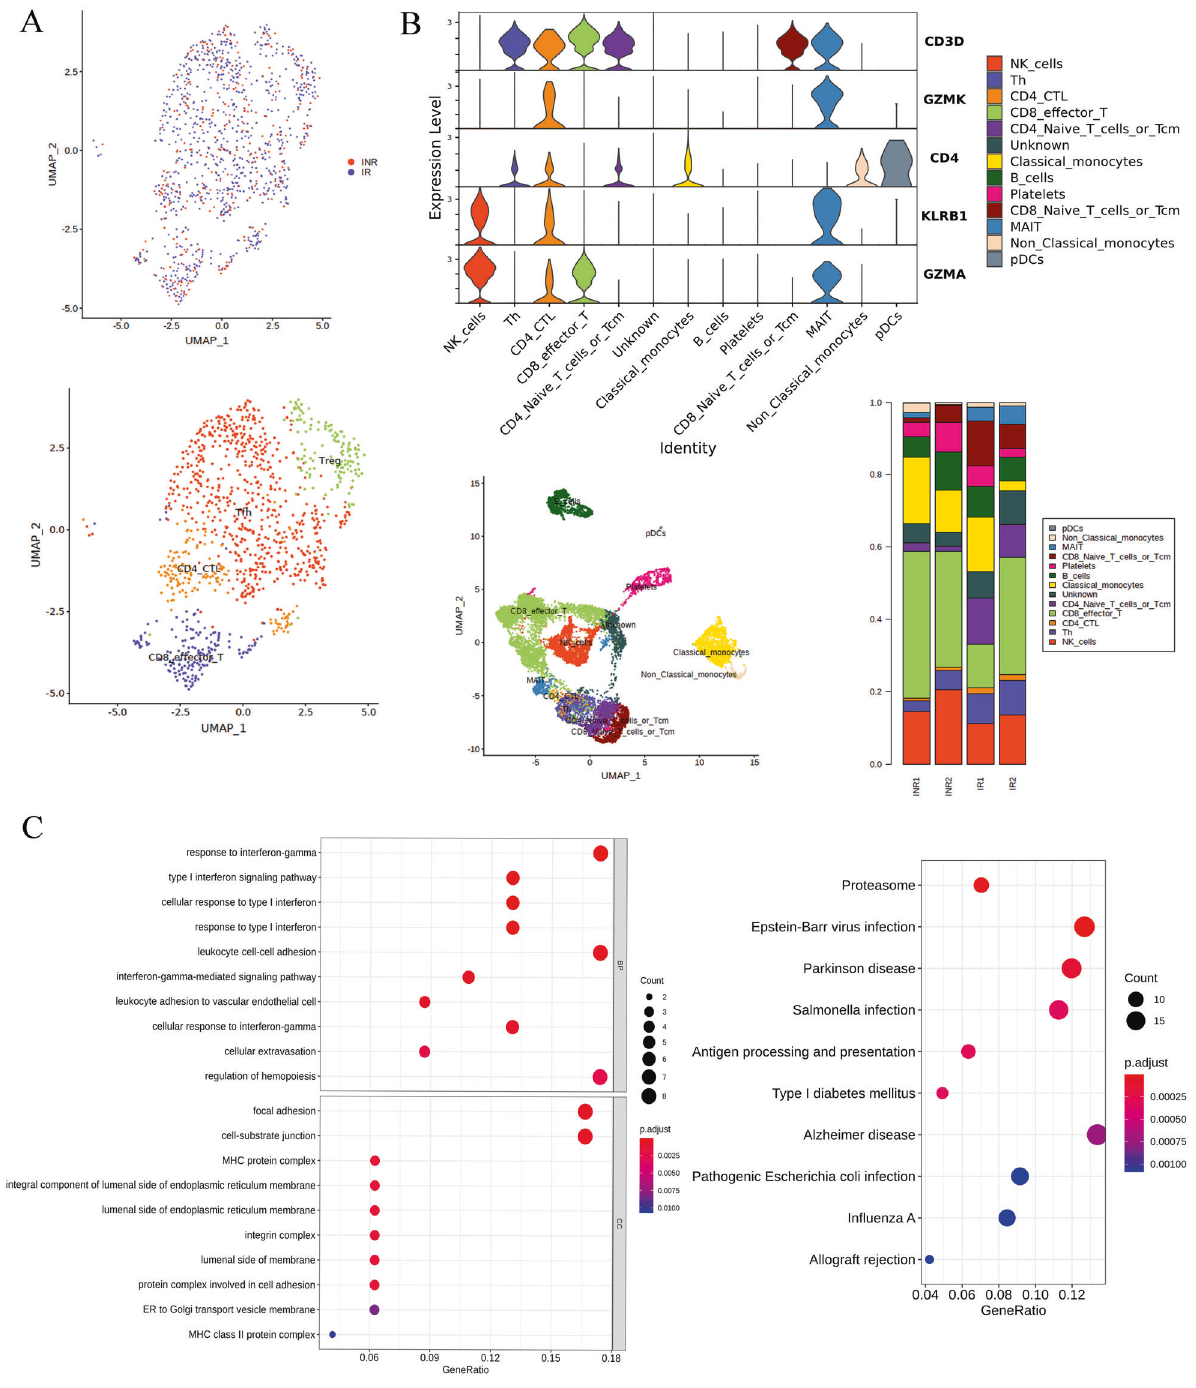
Fig. 5 Pro fi le of Th cells in INRs. A Two-dimensional UMAP visualization of Th cells using the Seurat R package. Different colors represent two groups (up). Different colors represent different cell subsets (down). B Expression and proportion of cytotoxic genes in CD4 CTL. C GO and KEGG analyses conducted using DAVID for upregulated genes in CD4 CTL cells from INRs compared with